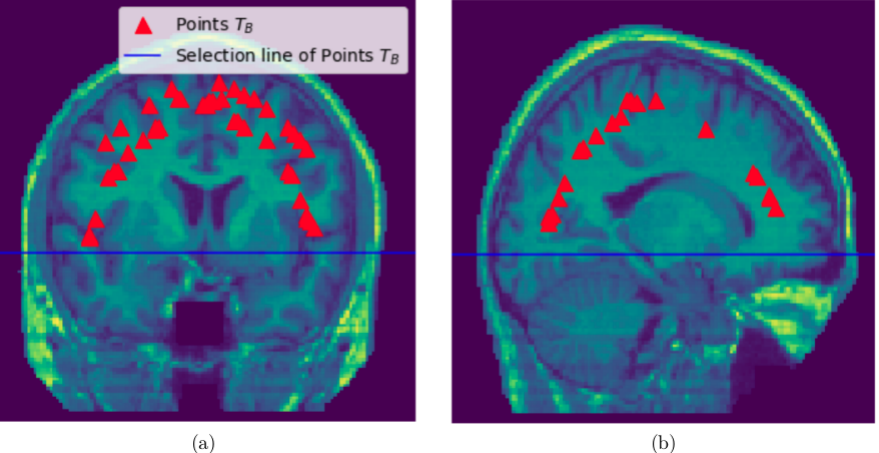
Figure 3. Sampling points T B within the brain: ( a ) Sampled slice coronal section showing the selection line and points sampled within the brain, ( b ) Sampled slice sagittal section section showing the selection line and points sampled within the